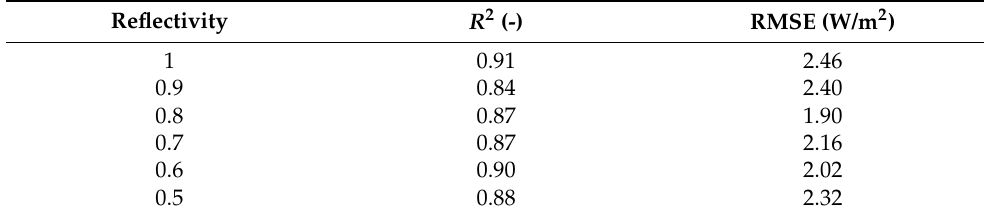
Table 5. Performance of the model of the potential maps of power for different solar reflectivity values. Reflectivity